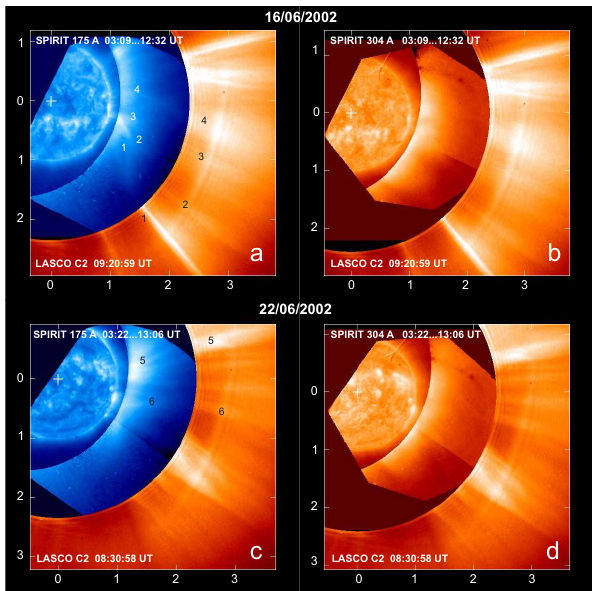
Fig. 5. Composite SPIRIT – LASCO C2 images: (a) and (c) the SPIRIT 175 image at R =0...2.3 with the LASCO C2 image (at R> 2.3), (b) and (d) the SPIRIT 304 ˚A image with the LASCO C2 image. Panels (a) and (b) show the SPIRIT images for 16 June 2002 summed over the period of 03:09...12:32UT, and the LASCO im- age taken on the same day at 09:20:59UT. Panels (c) and (d) show the SPIRIT images for 22 June 2002 summed over the period of 03:32...13:06UT, and the LASCO image taken on the same day at 08:30:58UT. The scales are in units of the solar radius (the origin marked by a cross corresponds to the solar center). The pair num- bers 1...6 designate the features which probably belong to the same structural elements seen in EUV and WL.